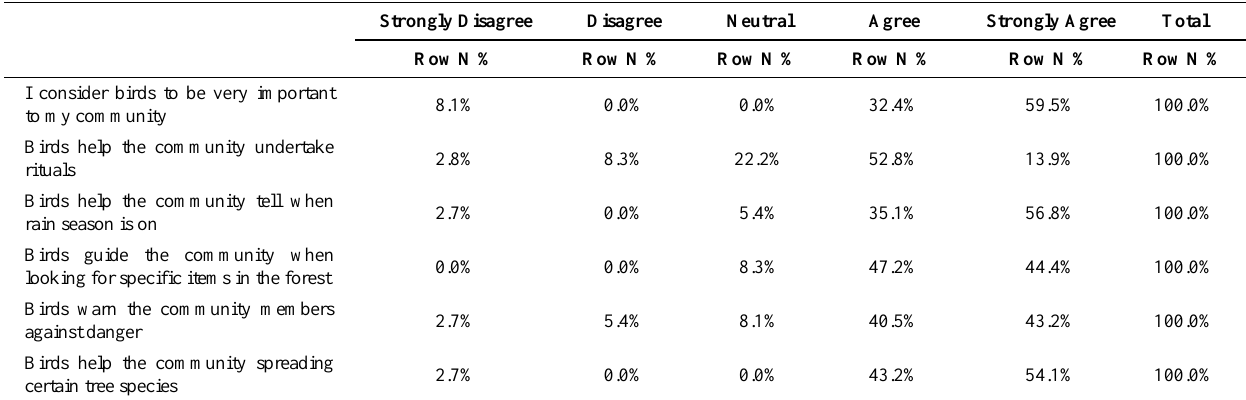
Table 1. Importance of birds in the